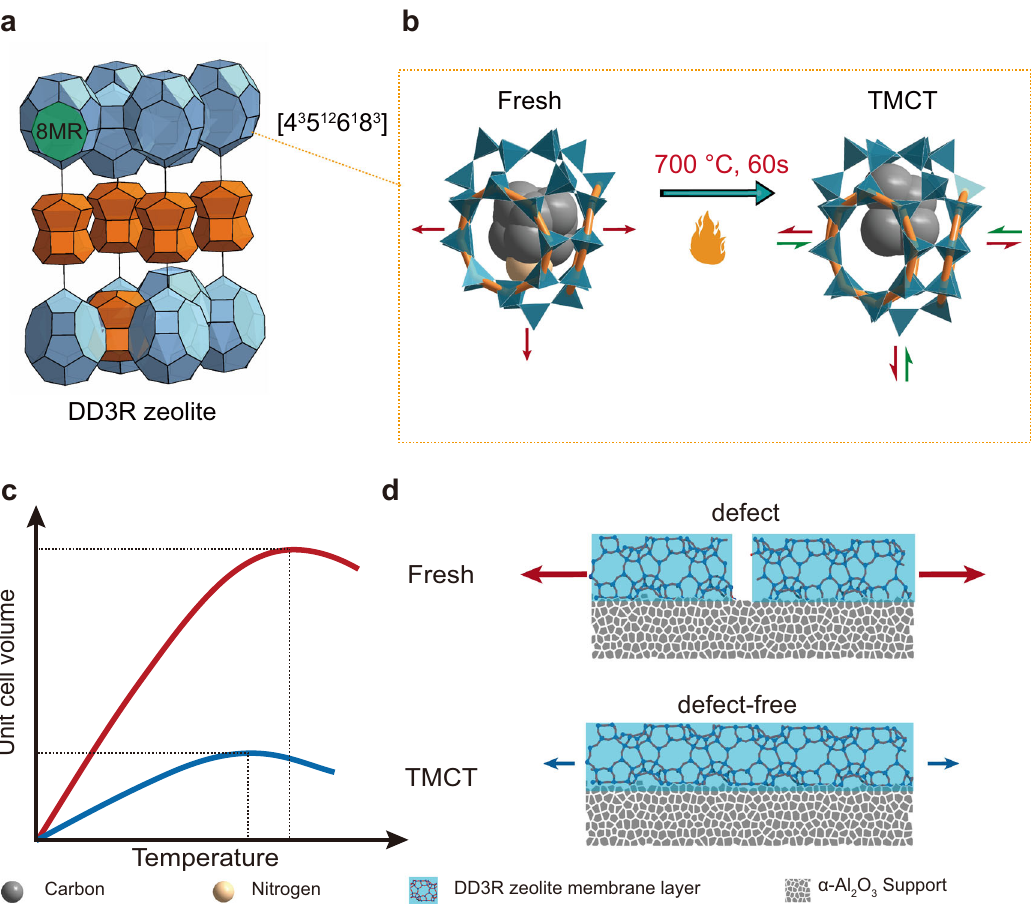
Fig. 1 Rational design of template modulated crystal transition (TMCT). a DD3R framework structure. The blue and orange cages denote the [4 3 5 12 6 1 8 3 ] and [4 3 5 6 6 1 ] cages, respectively. The green area denotes the 8MR window. To clearly observe the structure, the [5 12 ] cages were not displayed. b Illustration of [4 3 5 12 6 1 8 3 ] cage fl exibility occupied by template molecule (fresh) and carbons (TMCT). The orange rings represent the 8MR window of DD3R zeolite. c Illustration of expected temperature-dependent expansion of fresh (red line) and TMCT (blue line) DD3R zeolite. d Illustration of defective and defect-free DD3R zeolite membranes after the conventional calcination at 550 °C. Fresh, as-synthesized zeolite; TMCT, overheating at 700 °C for 1